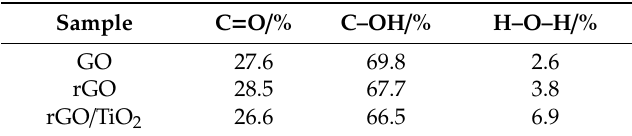
Table 2. Amount of various oxygenated groups before and after reduction of GO, calculated from the O1s XPS